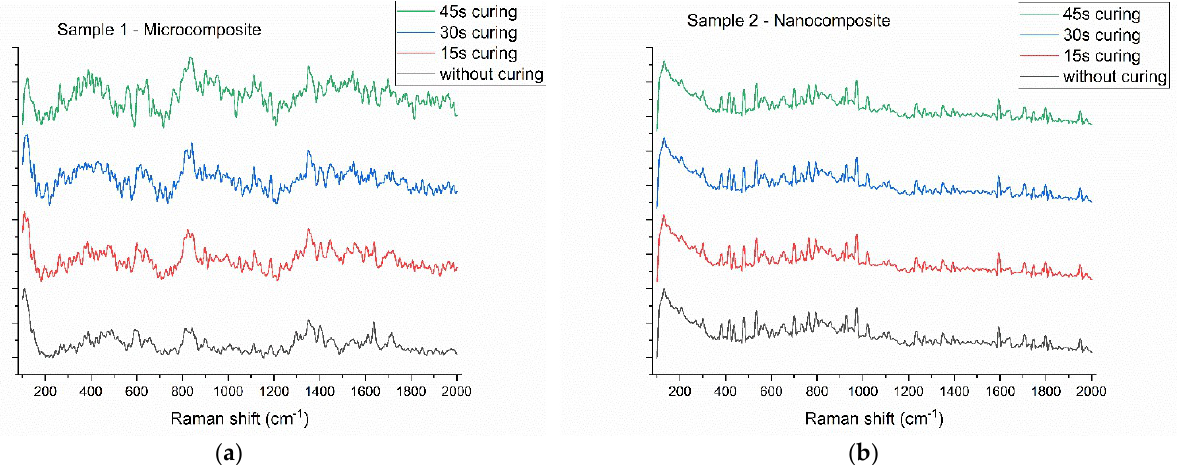
Figure 3. Raman spectra of the microcomposite ( a ) and nanocomposite ( b ) following different curing intervals.